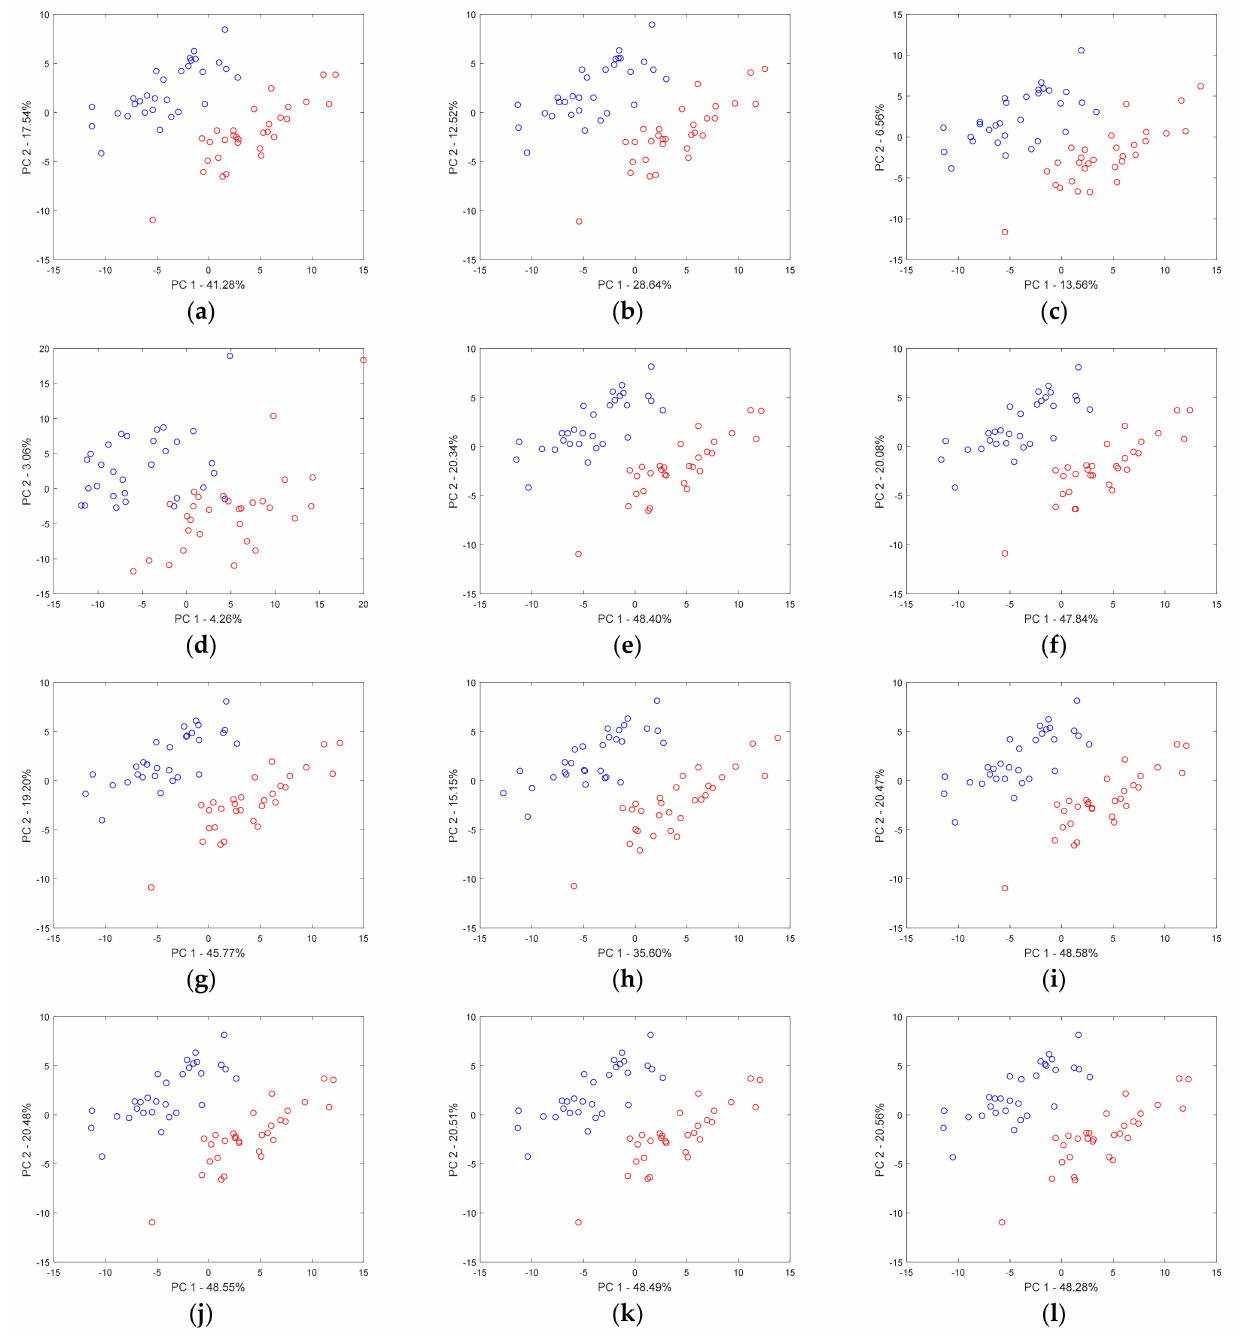
Figure 3. Projections of samples described by the first-order chromatograms on the space of the first two principal components: ( a – d ) the increasing level of Gaussian noise (4.34%, 8.67%, 17.35%, and 43.37% concerning the intensity of the largest peak, respectively), ( e – h ) the increasing level of heteroscedastic noise (2.39%, 4.78%, 9.56%, and 23.91% concerning the intensity of the largest peak, respectively), and ( i – l ) increasing level of baseline (0.5%, 1%, 2%, and 5% concerning the intensity of the largest peak,